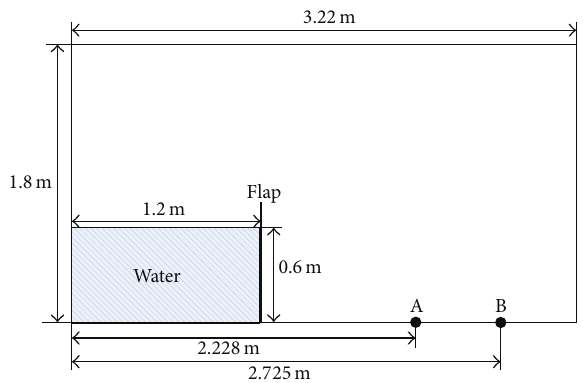
Figure 1: Configuration of the dam break